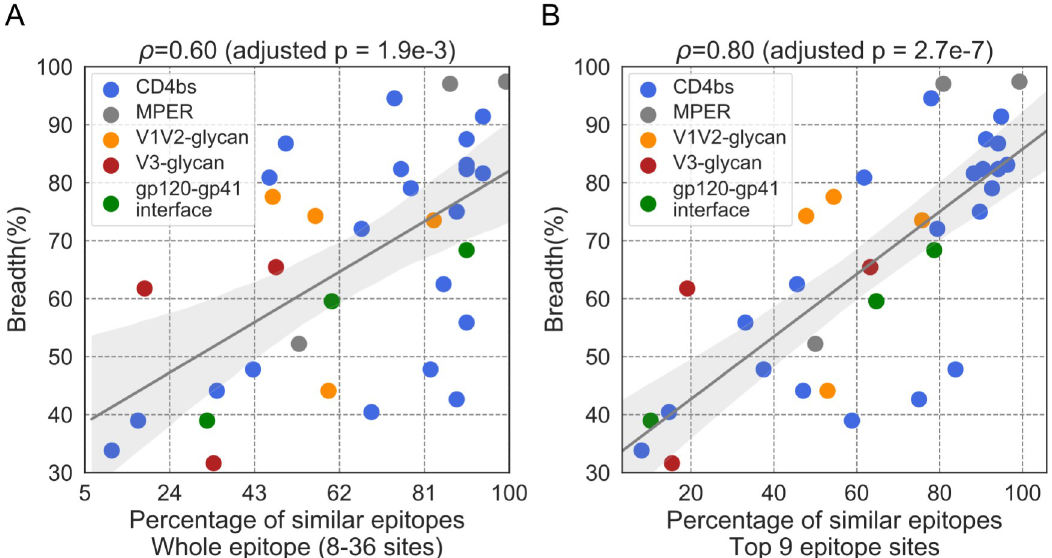
Fig 4. Relationship between neutralization breadth and the epitope similarity to susceptible strains. The epitope similarity of a given antibody was calculated by comparison to the three most susceptible strains to this antibody in a panel of 136 viruses; values are reported for the whole epitope (A) or only for the top 9 epitope sites (B). The 95% confidence interval of the linear regression line was determined by 1000 bootstrap